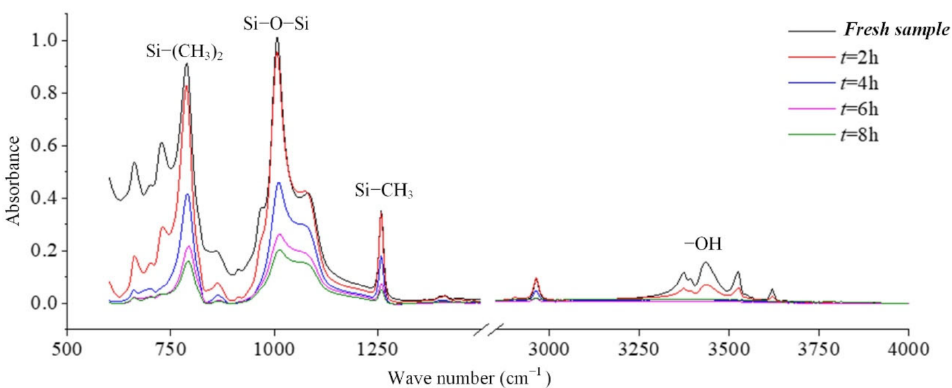
Figure 8. The effect of withstand time on the FTIR spectra ( γ 20 = 1000 µ S/cm, AC 3.6